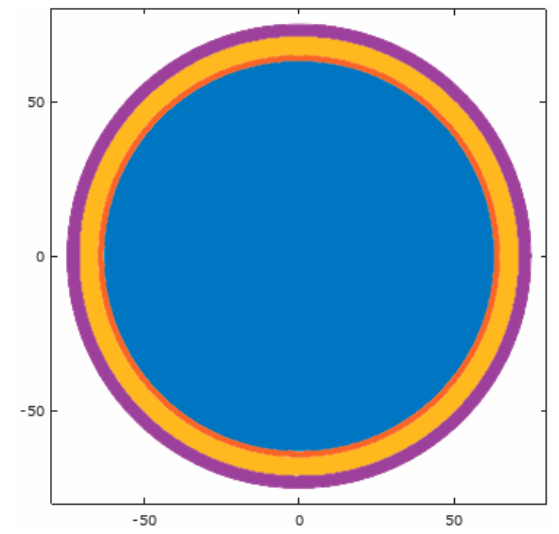
Figure 1. Cross-section through the center of the spherical model.